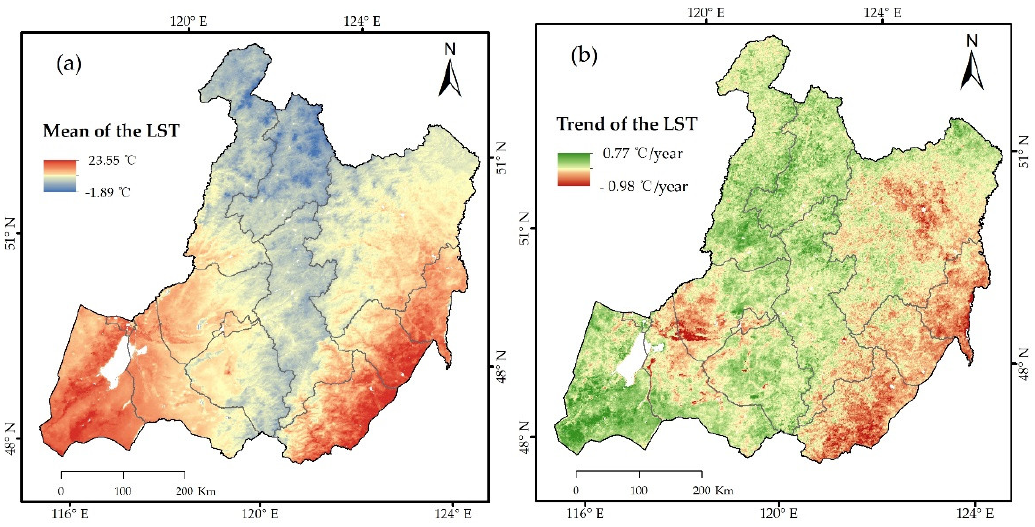
Figure 6. Distribution of ( a ) mean of Land Surface Water Index (LSWI) and ( b ) trend of LSWI in 2001–2018.